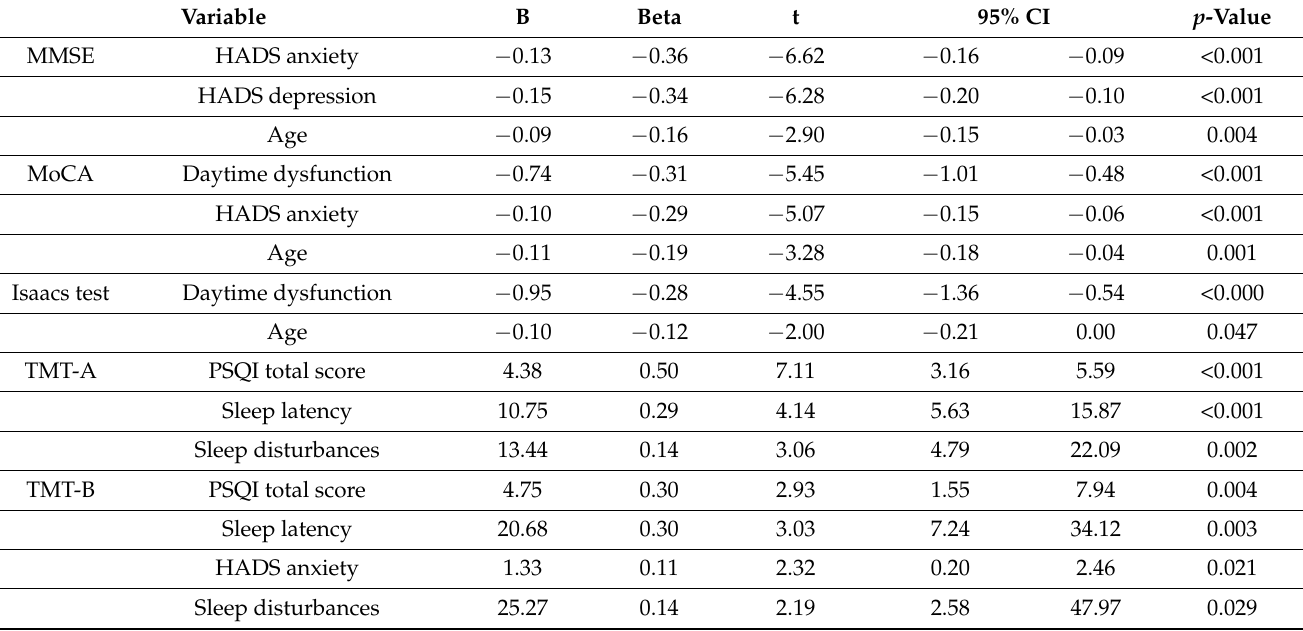
Table 5. Multivariate linear regression